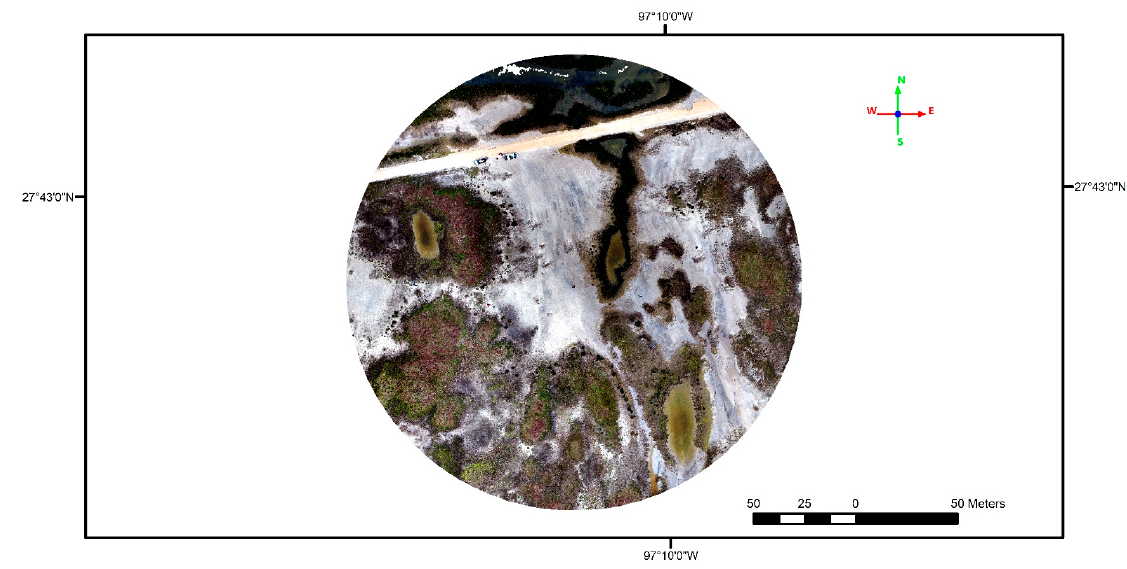
Figure 3. Unmanned Aircraft System based Structure-from-Motion (UAS-SfM) point cloud colorized by the camera’s Red-Green-Blue (RGB) brightness values.